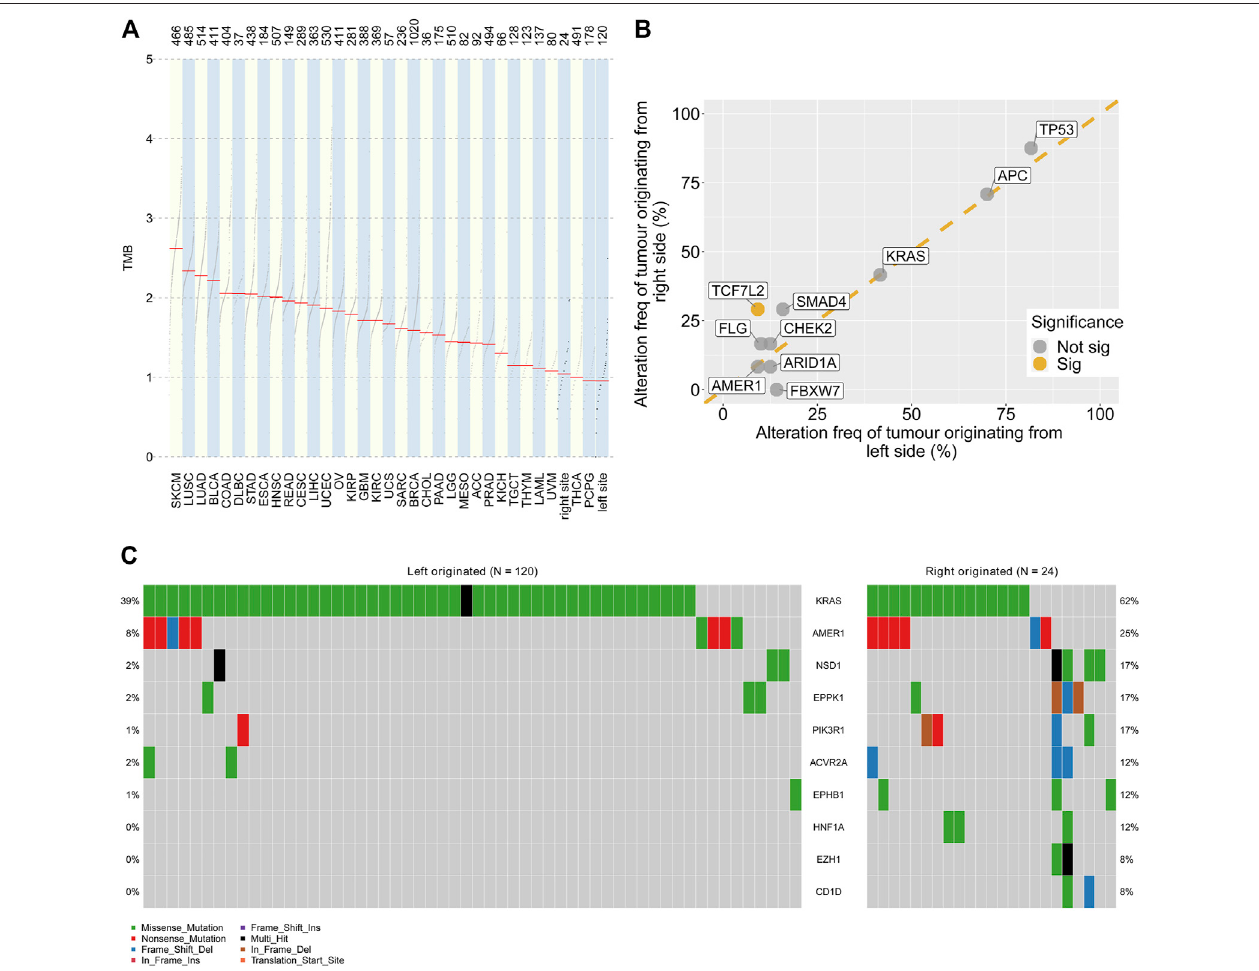
FIGURE3| Genomicalterationsbyprimarysite (A) ComparisonoftheTMBvaluesinCRLMsoriginatingfromtheleftandrightsidesofthecolonwiththoseinother tumourtypes. Datasource:TCGA database (B) Genomic alteration frequencyanalysisbyprimary tumoursite (C) Oncoplot ofgenealterations withdifferentfrequencies in tumours originating from the left and right sides of the colon. TMB: tumour mutation burden; TCGA: The Cancer Genome Atlas.